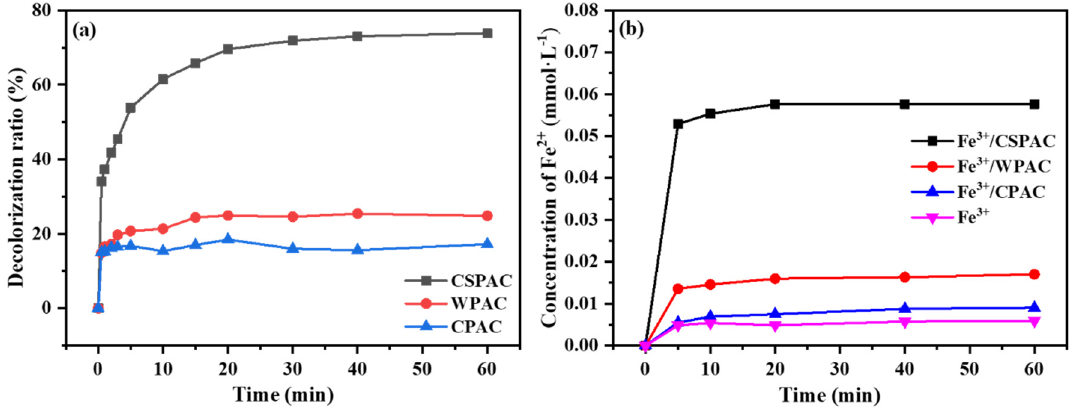
Figure 2. ( a ) Decolorization rate of ARG adsorption by CSPAC, WPAC, and CPAC (100 mg/L ARG, 0.4 g/L PAC (75 μ m particle size), pH = 3). ( b ) Concentration of Fe 2+ generation in Fe 3+ /CSPAC, Fe 3+ /WPAC, and Fe 3+ /CPAC systems (0.1 mmol/L FeCl 3 , 0.4 g/L PAC (75 μ m particle size), pH = 3).